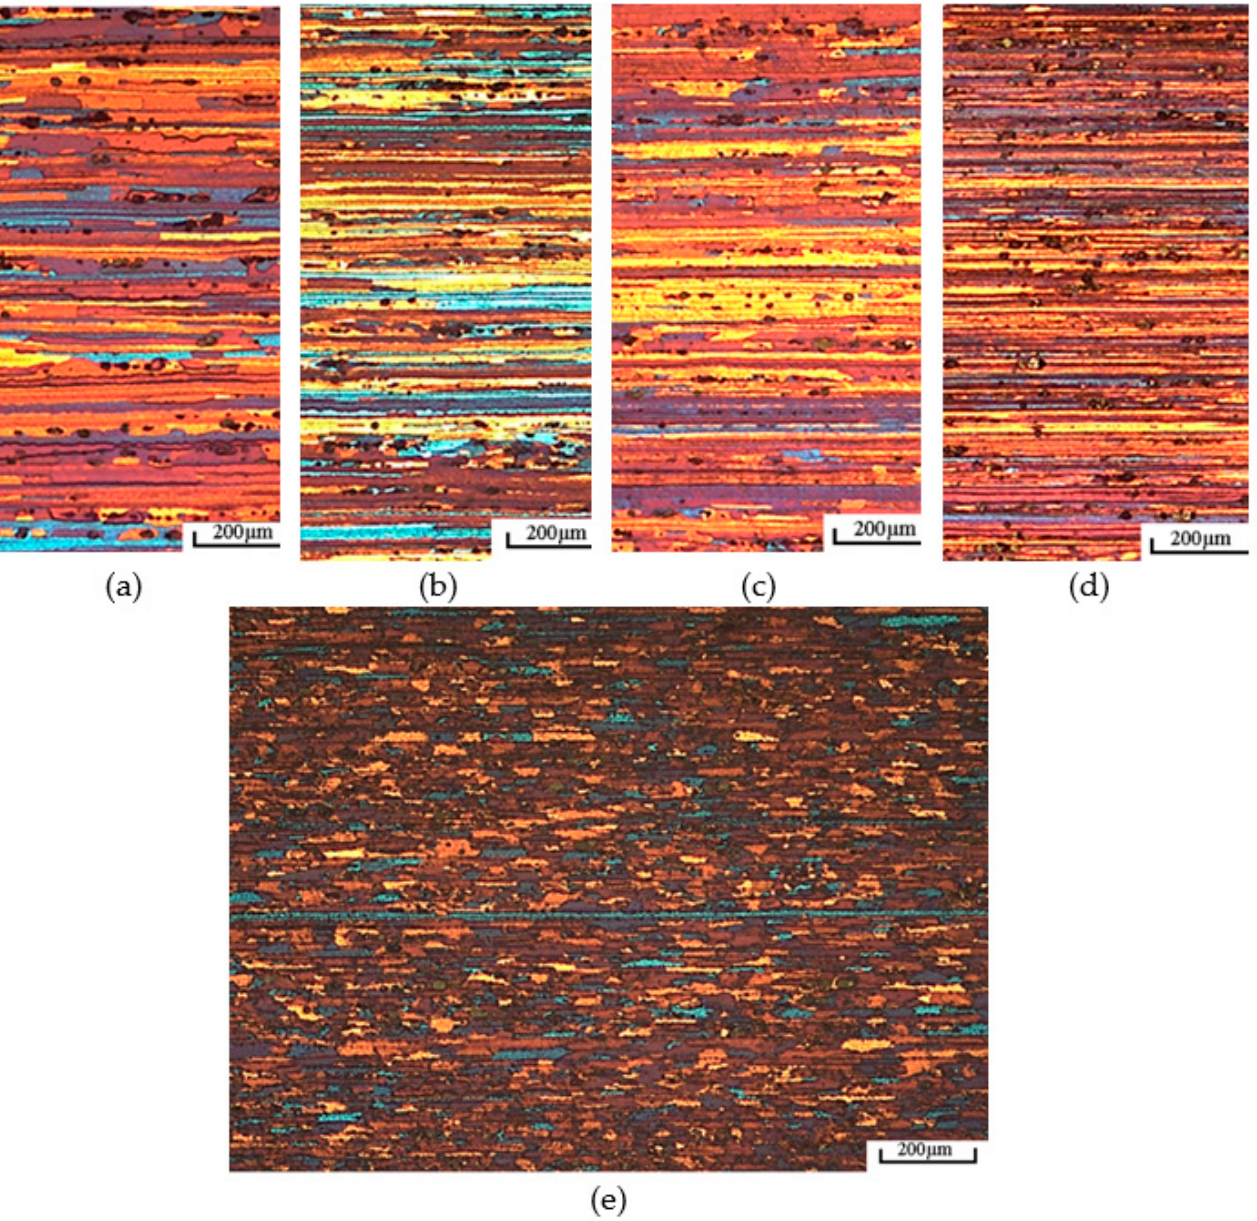
Figure 11. Change in the microstructure of the Al Mg6 Mn0.7 (1565 ch) strip during hot rolling in the continuous hot rolling group. Longitudinal section. 200:1 scale: ( a ) before F1; ( b ) after F1; ( c ) before F2; ( d ) after F5, ( e ) after hot rolling with slow cooling.